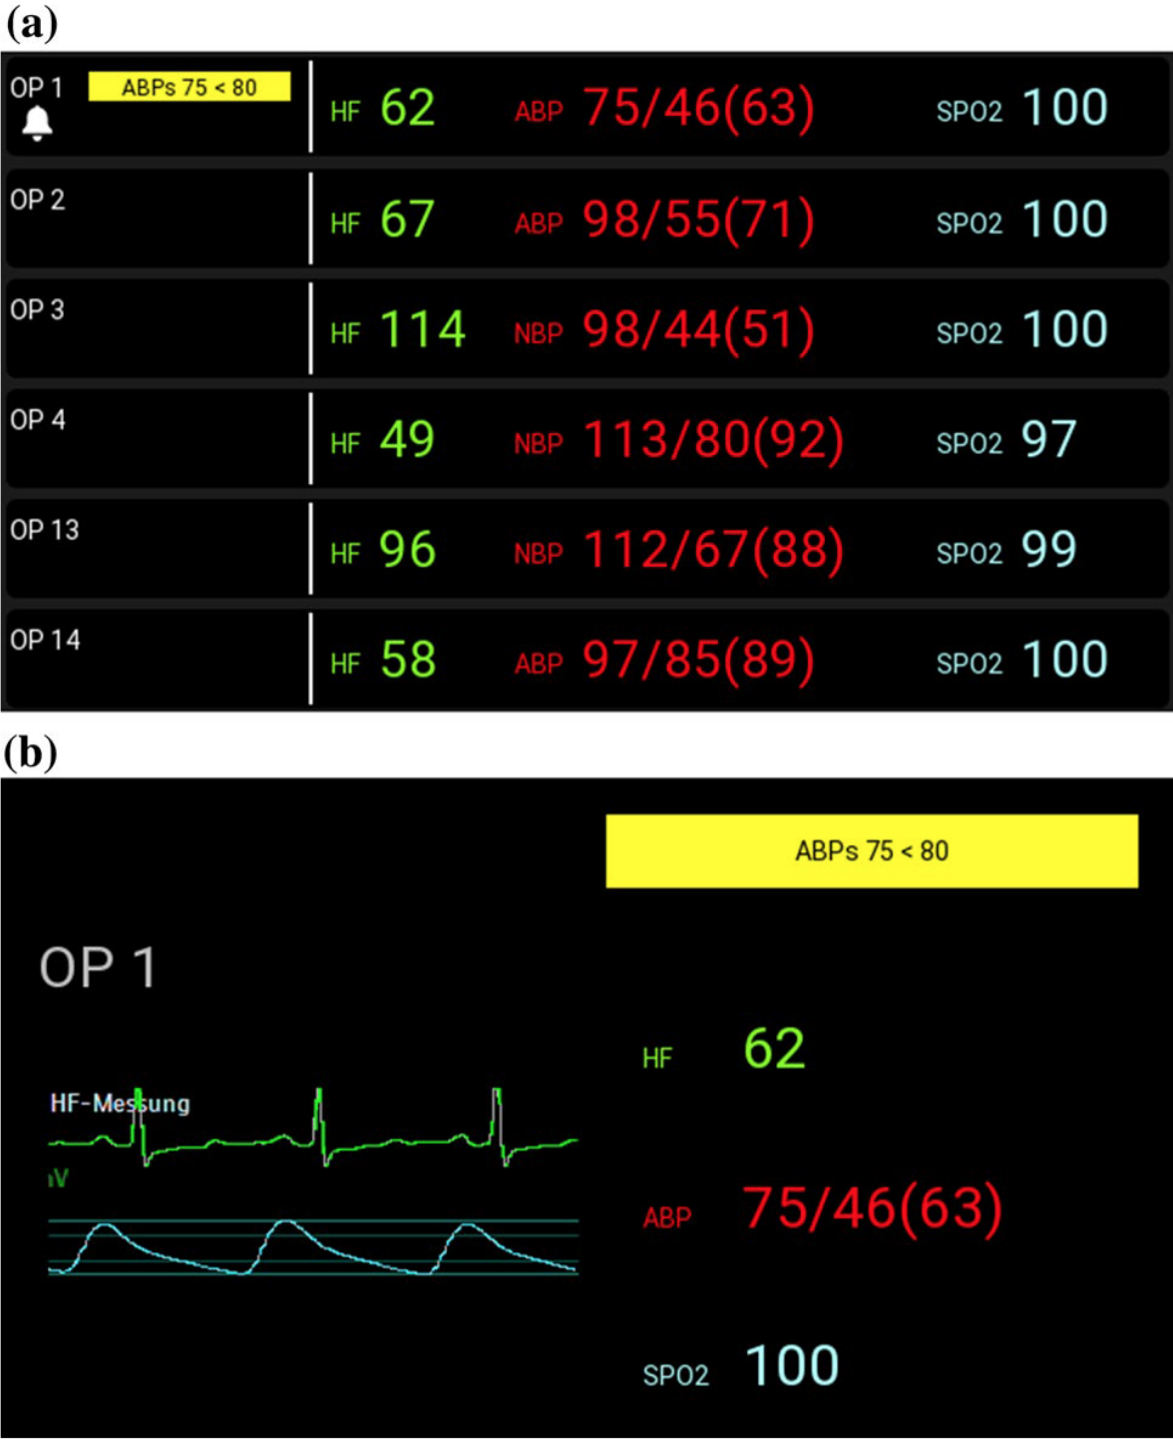
Figure 19. Schlosser et al's [33] display, as presented in the head-mounted displays (HMDs) prototype. (A) alarms are displayed on the left side of the screen, and the digital values for heart rate, blood pressure, and saturation of peripheral oxygen are displayed on the right side. (B) A second screen of Schlosser’s display was designed to present more details (such as a snapshot of the electrocardiogram curve) for one specific patient. In addition to the visual alarms, auditory alarms were displayed on the HMDs via bone conduction. To interact with the device, a button on the HMDs had to be pressed to cycle through the patients. (Permission to use the image obtained through RightsLink.) ABP: arterial blood pressure; HF: heart rate; NBP: noninvasive blood pressure; OP: operating room; SpO 2 : oxygen